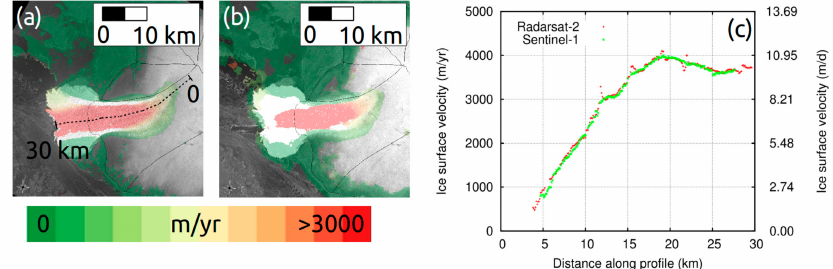
Figure 17. Ice velocity maps on Vavilov Ice Cap (Severnaya Zemlya) from ( a ) Radarsat-2 WUF data of 26-11/20-12-2016 and ( b ) Sentinel-1 data of 30-11/12-12-1016 ( c ) and inter-comparison alongthe centre flow line plotted in ( a